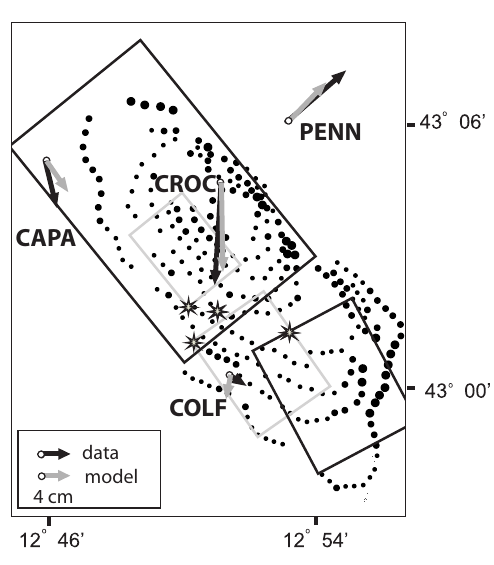
Fig. 5. Geometry used by Belardinelli et al. (2003) for the sources of events 1 and 2 and the other two minor events occurred on 3 and 6 October 1997 (grey boxes), whose epicentres are represented by black open stars. GPS data of horizontal displacement in the four stations located within 15 km from the main- shock epicentre are compared to model results. Re- sults of the best model for event 2 according to joint inversion of GPS (at the four stations indicated) and DInSAR data are shown (model a in table II of the mentioned paper). Slant range displacement seen by DInSAR data is assumed to be known in 258 «data points» (black dots). Dot size scales with the loga- rithm of the squared residual between model and DInSAR datum, as evaluated in the dot location. For the fault of event 2, the inverted value of the top edge depth is 70 m. Faults are assumed as rectangular dis- locations in an elastic homogeneous